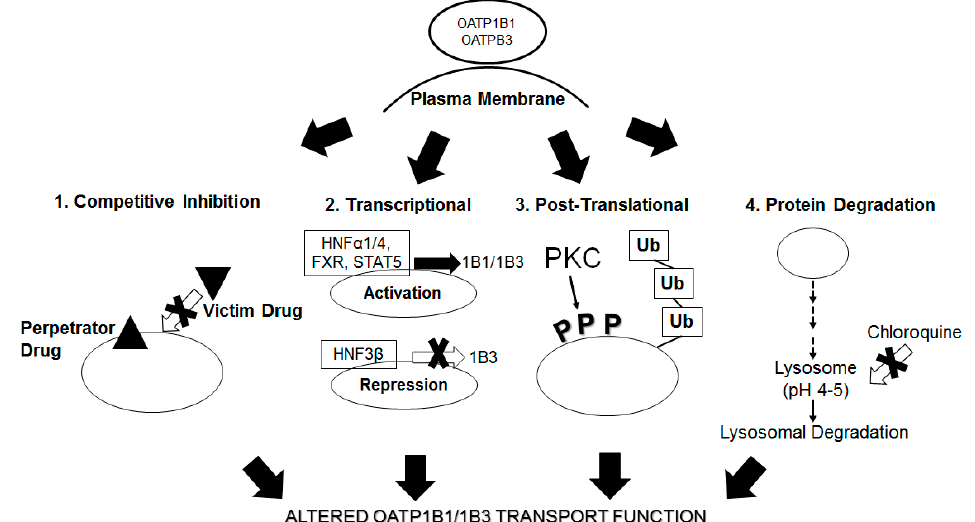
Figure 2. Summary of regulation of OATP1B1 and 1B3 transport function. OATP1B1 and 1B3 transport proteins can be regulated at the ( 1 ) plasma membrane by competitive inhibition; ( 2 ) by transcriptional factors than can repress or activate transcription; ( 3 ) post-translational modification by phosphorylation (P) or ubiquitination (Ub) and ( 4 ) by alteration of protein degradation. All four mechanisms are important for the regulation of OATP1B1 and OATP1B3 optimal transport function of its substrates.